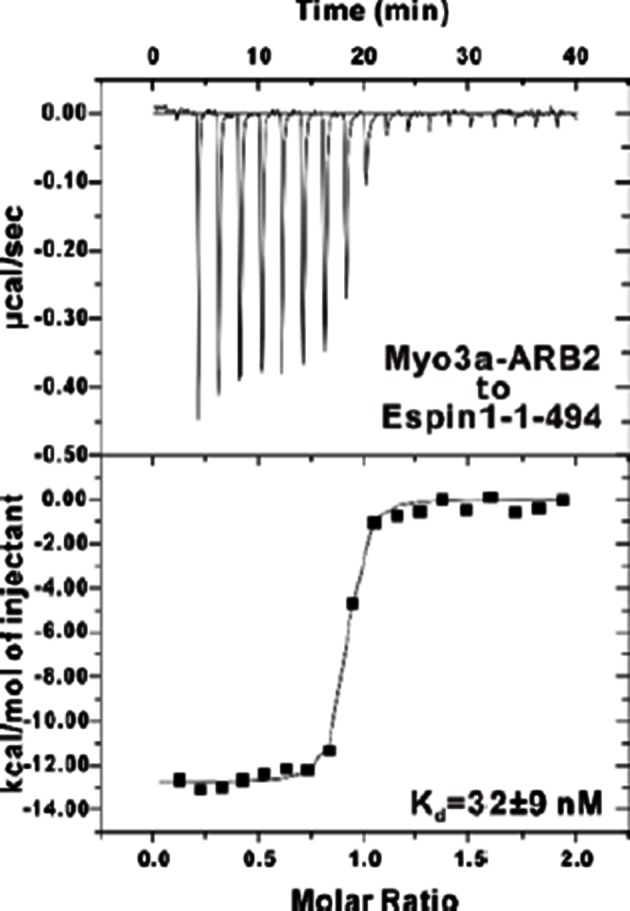
ITC results showing that Myo3a-ARB2 binds to Espin1-1-494 with similar affinity compared to Espin1-AR.